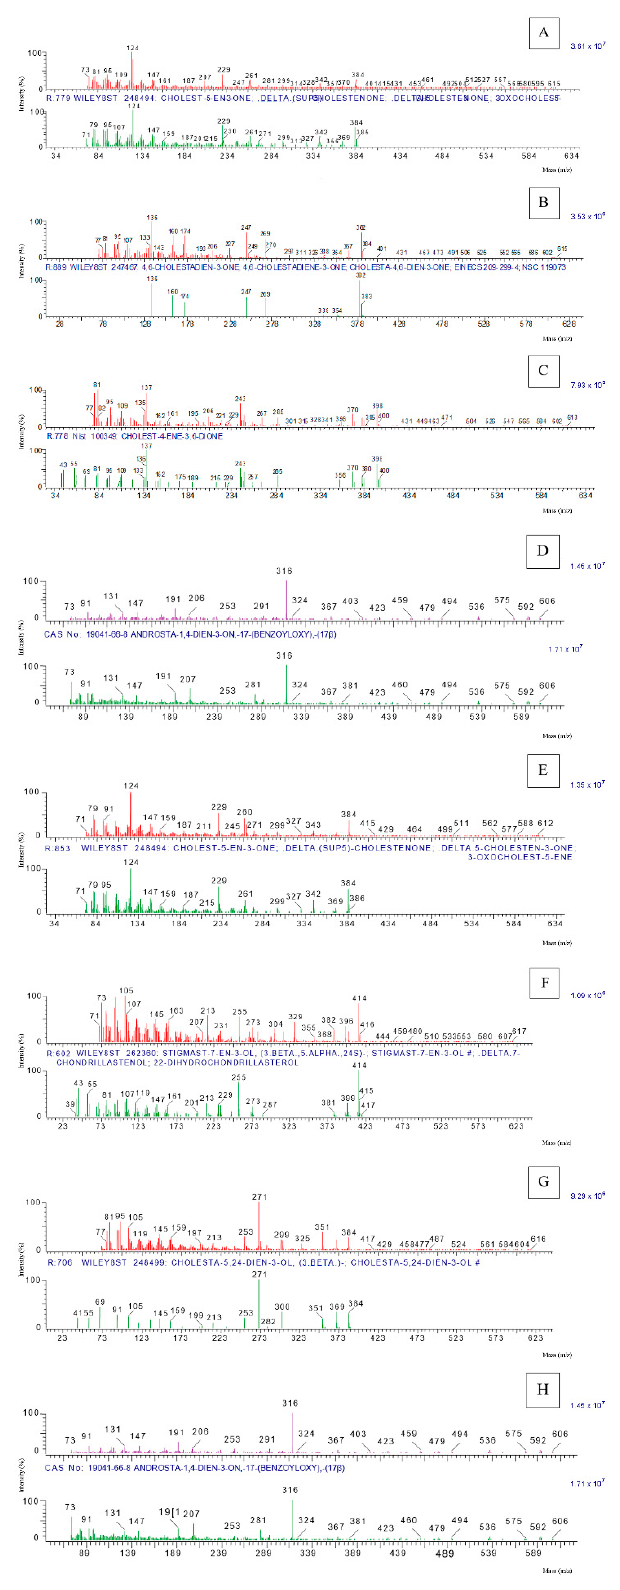
Figure 4. Chromatograms for the identification of sterol substances that could potentially act as sex hormones, isolated from the adult bodies of P. chalcographus (method without KOH derivation) ( A – D ) and I. typographus ( E – H ) species. Red color = female, and green color = male.